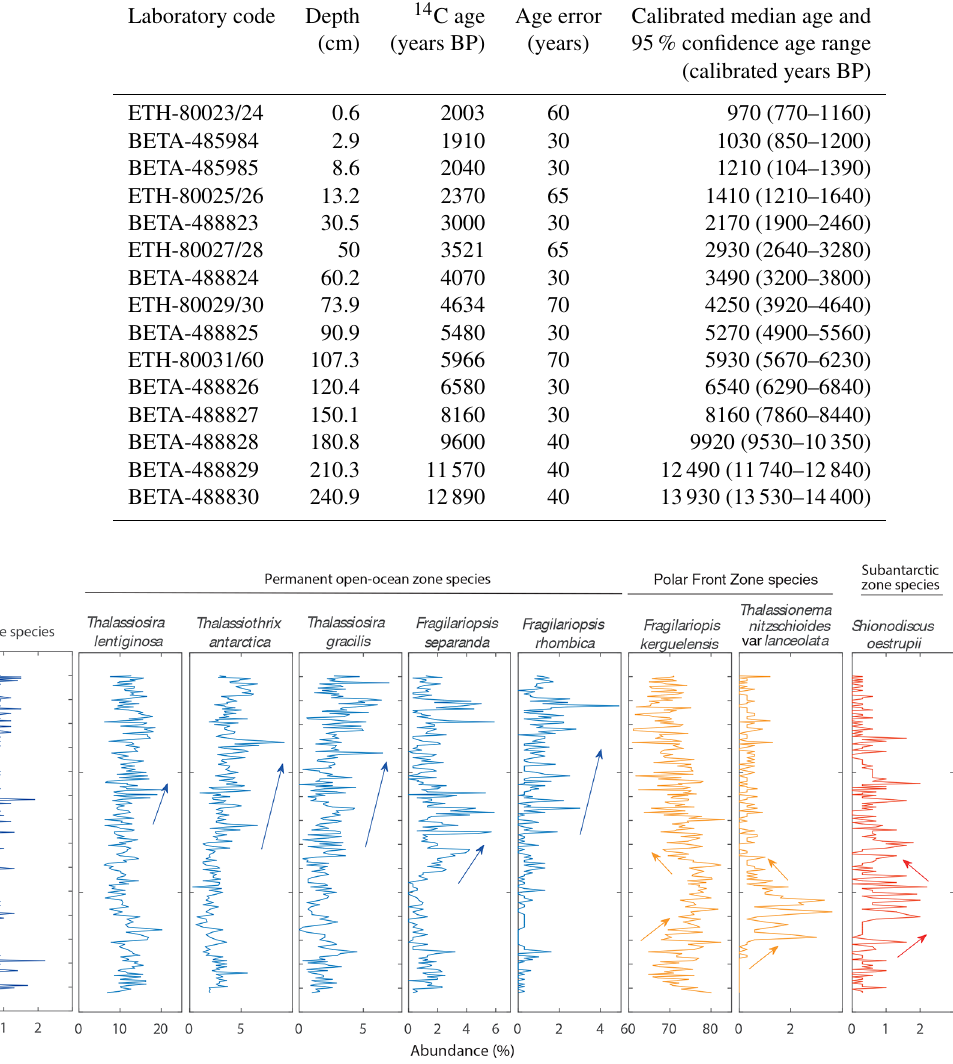
Table 1. AMS radiocarbon dates and calibrated age estimates.